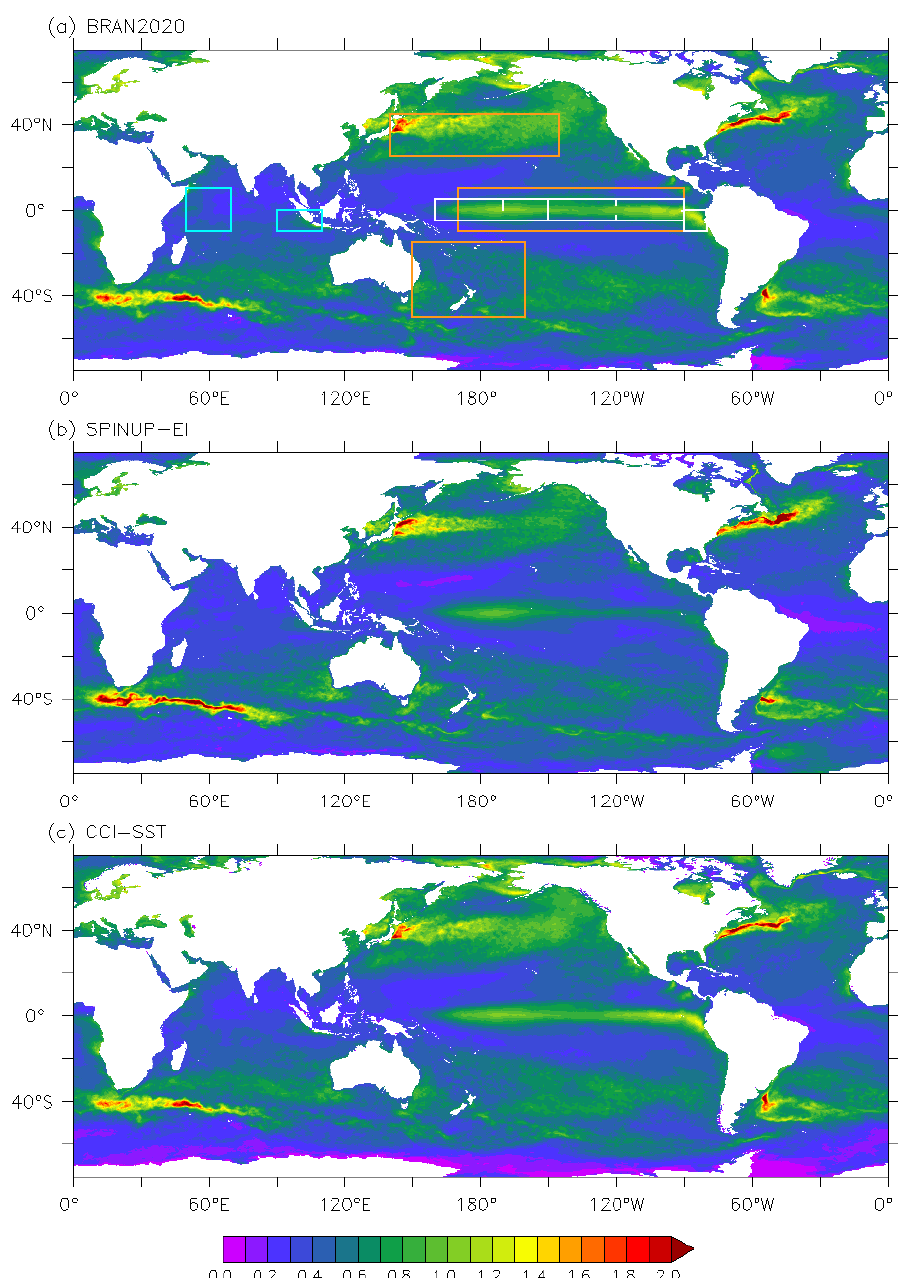
Figure 11. SST variability as the standard deviation of climatological anomalies in BRAN2020 (a) , Spinup-EI without data assimilation (b) and CCI-SST (c) over the years 2000–2009. Top panel shows the locations for climate indices shown in Fig. 10: ENSO indices in white, IPO in orange and IOD in